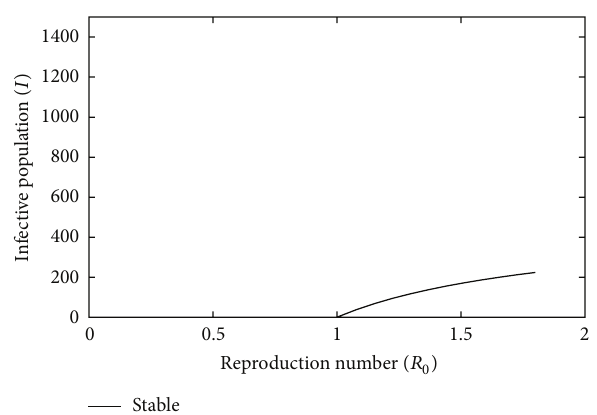
Figure 5: Forward bifurcation diagram for 𝛿 < 1 for the parameter values 𝑏 1 = 10 , 𝜆 1 = 0.0005 , 𝛼 = 0.01 , 𝜇 1 = 0.01 , 𝛾 = 0.01 , 𝜆 2 = = 60 , 𝜇 = 0.5 . 0.0003 , 𝑏 2 2